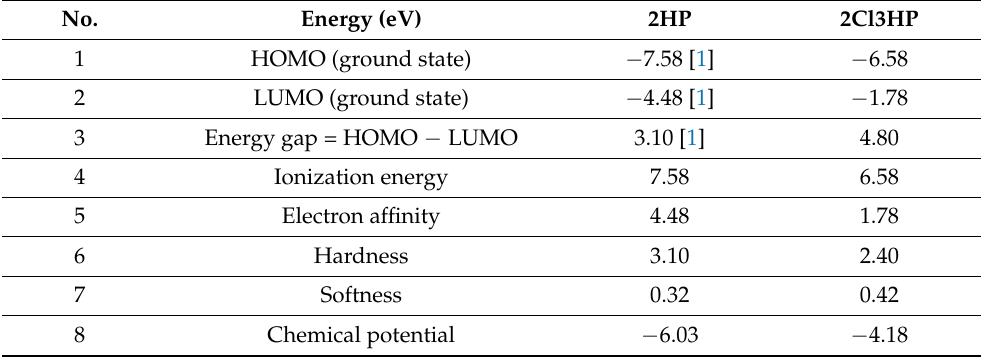
Table 1. Comparison analysis of hydrazinopyrazine derivatives with computed HOMO and LUMO energies, energy gaps, and other parameters in eV computed in vacuo at B3LYP/6-311+G** level of